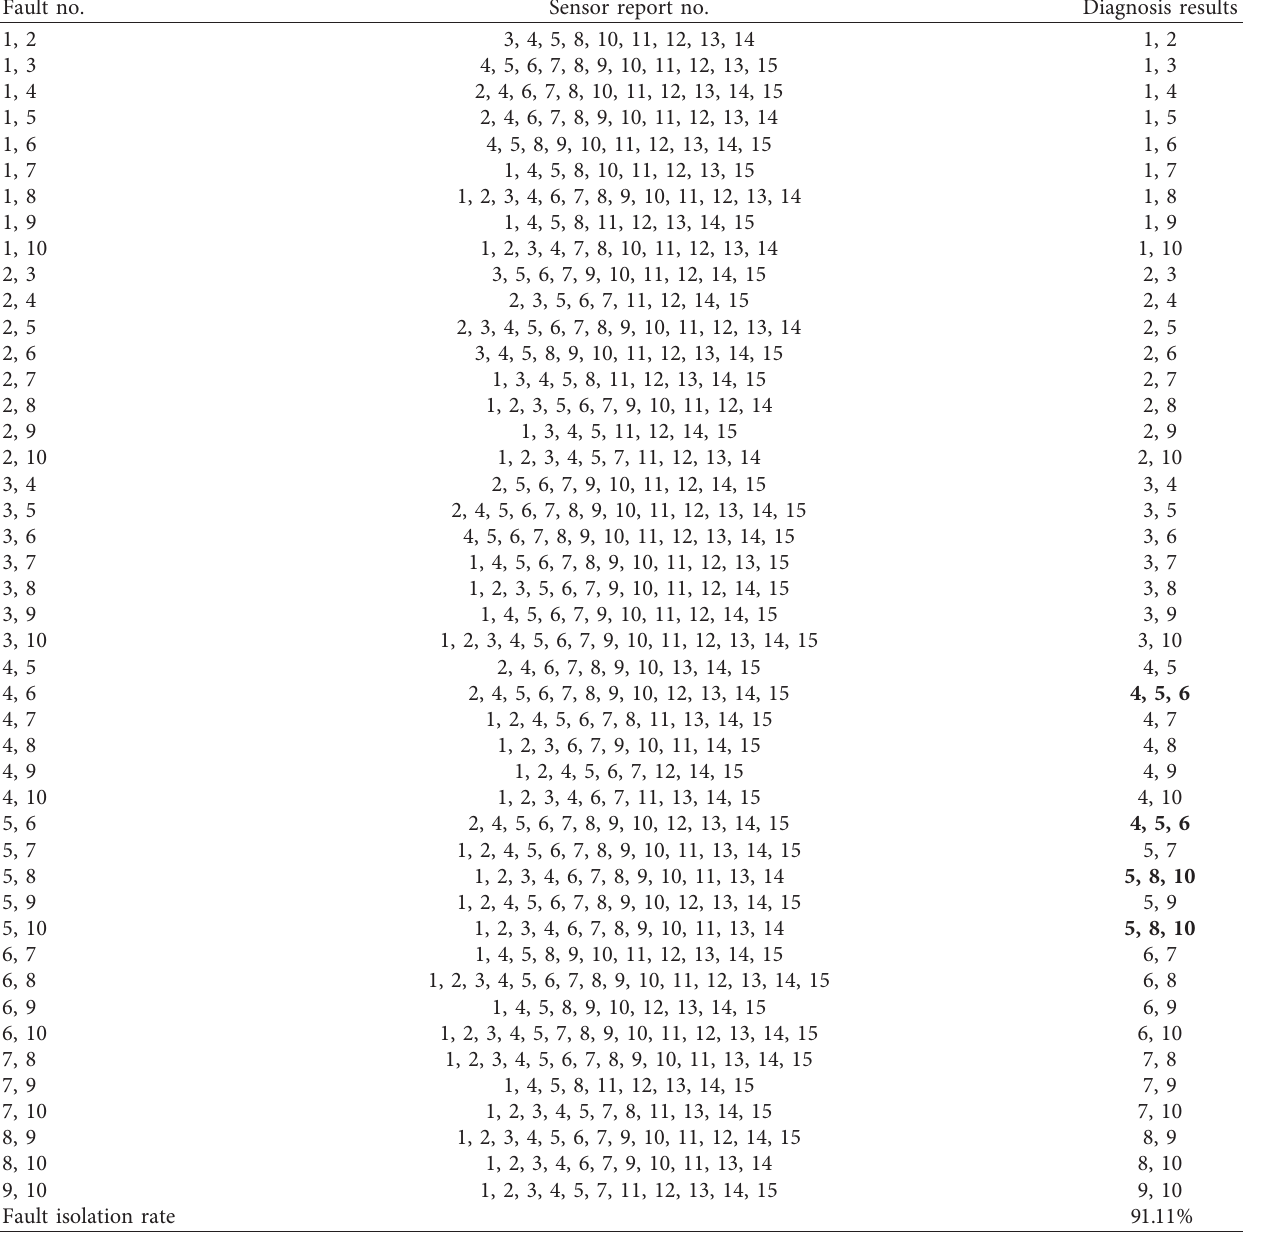
Table 2: The results of double-fault diagnosis with Lagrange relaxation-particle swarm optimization algorithm. Fault